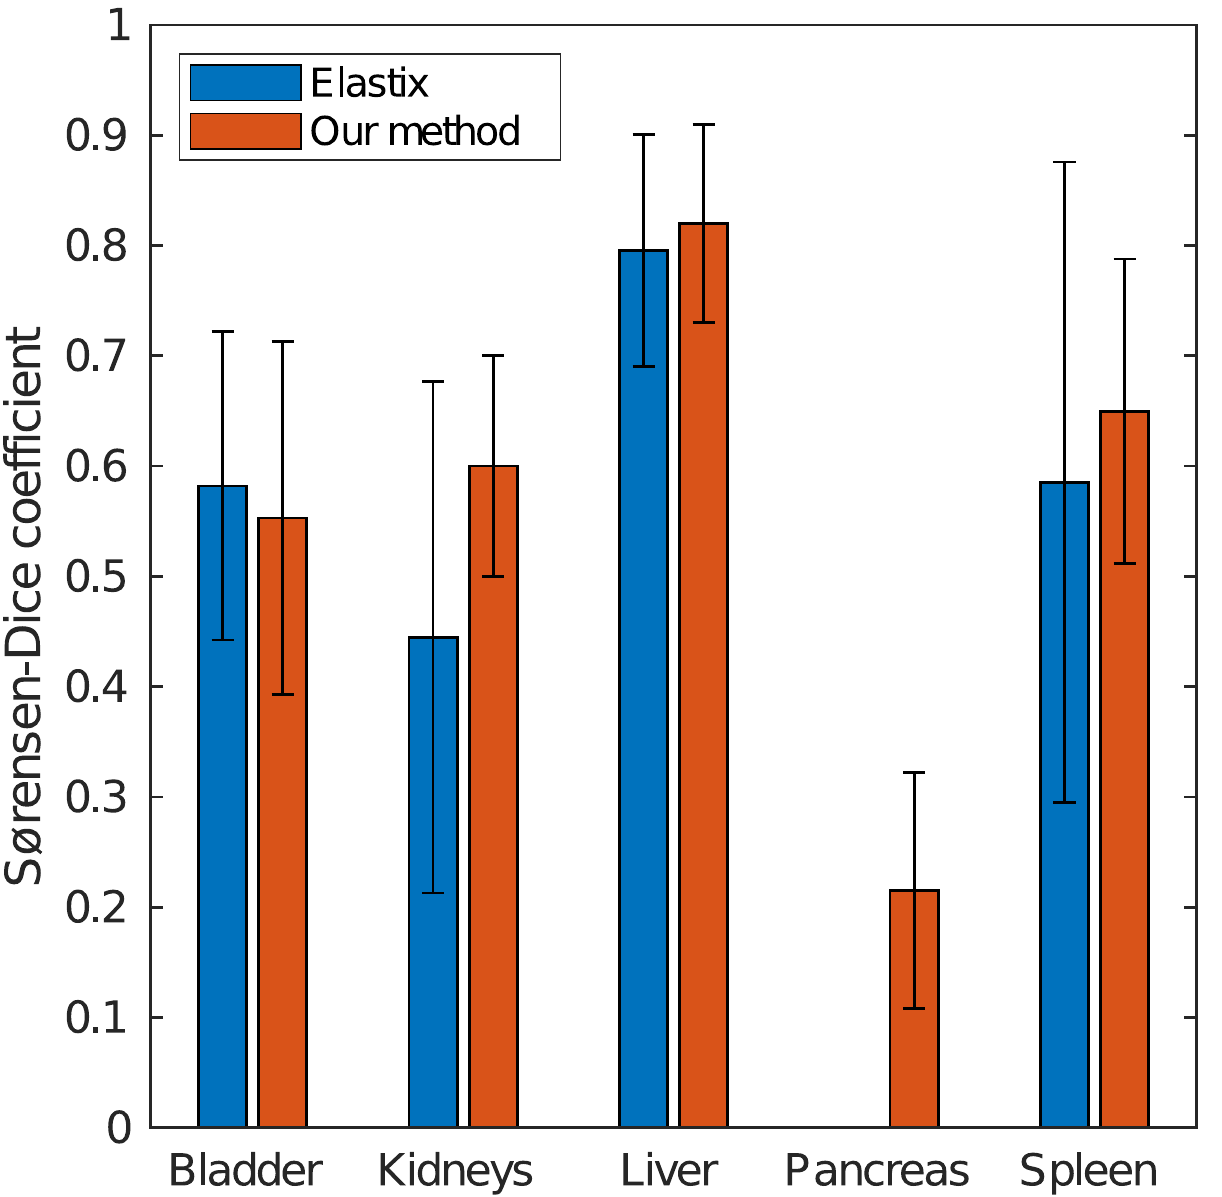
Fig 5. Plot of the mean and standard deviation of the S ø rensen–Dice coefficient for the overlapping of segmented